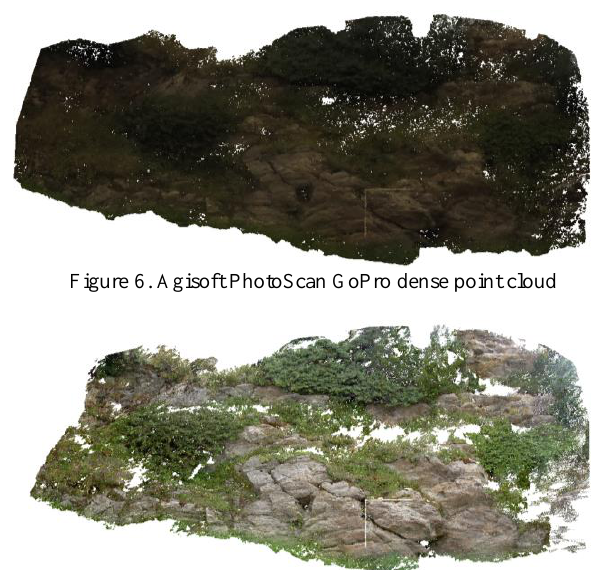
Figure 12. Pix4D Konica dense point cloud